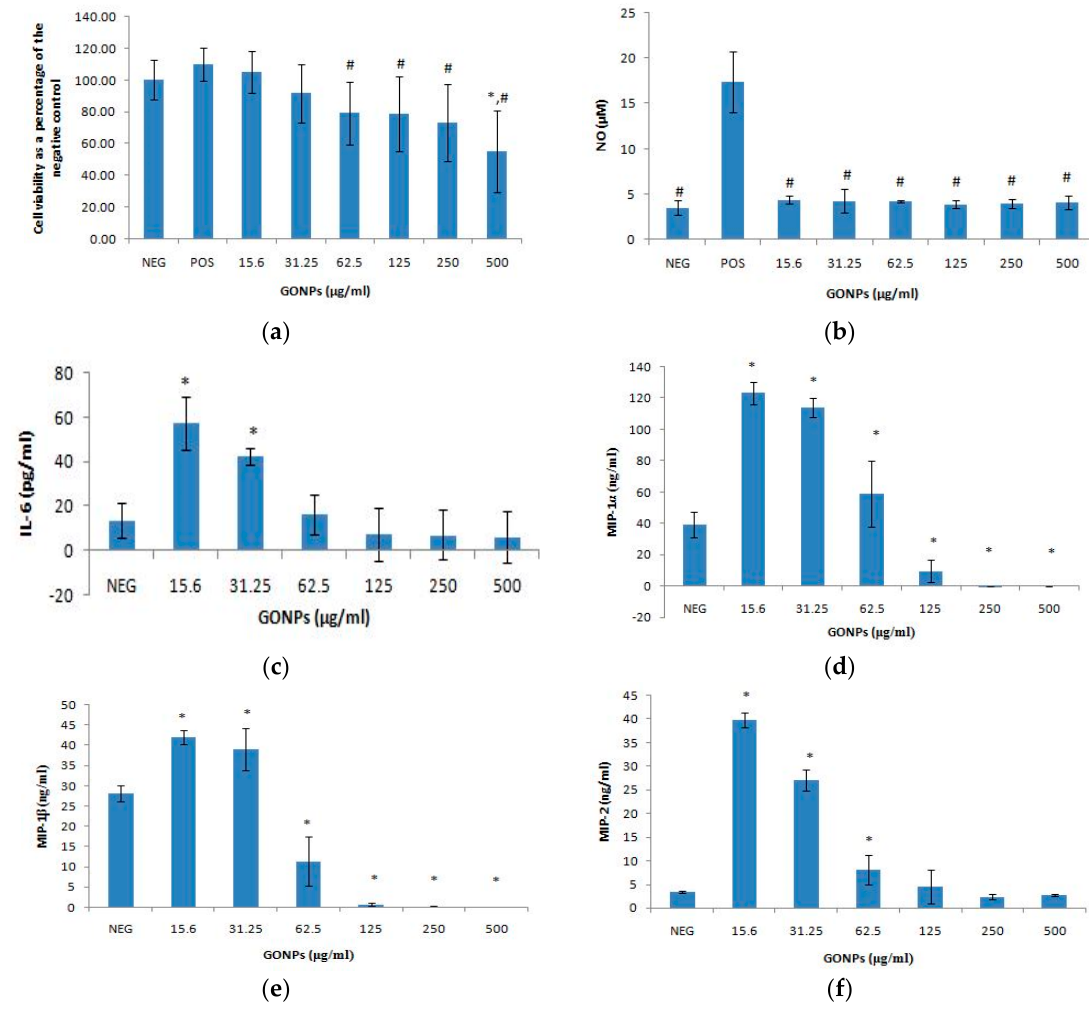
Figure 1. Murine macrophage, RAW 264.7 cells after treatment with GONPs. Parameters assessed ( a ) cell viability; ( b ) nitric oxide production; ( c ) Interleukin 6 (IL-6) production; ( d ) Macrophage inflammatory protein 1 alpha (MIP-1 α ) levels. Positive control not represented (803.85 ± 353.70 ng/mL MIP-1 α ); ( e ) MIP-1 β levels. Positive control not represented (1127.19 ± 468.69 ng/mL MIP-1 β ); and ( f ) MIP-2 levels. Positive control not represented (307.39 ± 171.86 ng/mL MIP-2). Data represents mean ± SD with n = 9. Bars marked with symbols indicate significant difference to control ( p < 0.01). Significance demarcated by: *—significantly different compared to negative control ( p < 0.001), # —significantly different compared to positive control ( p ≤ 0.005).